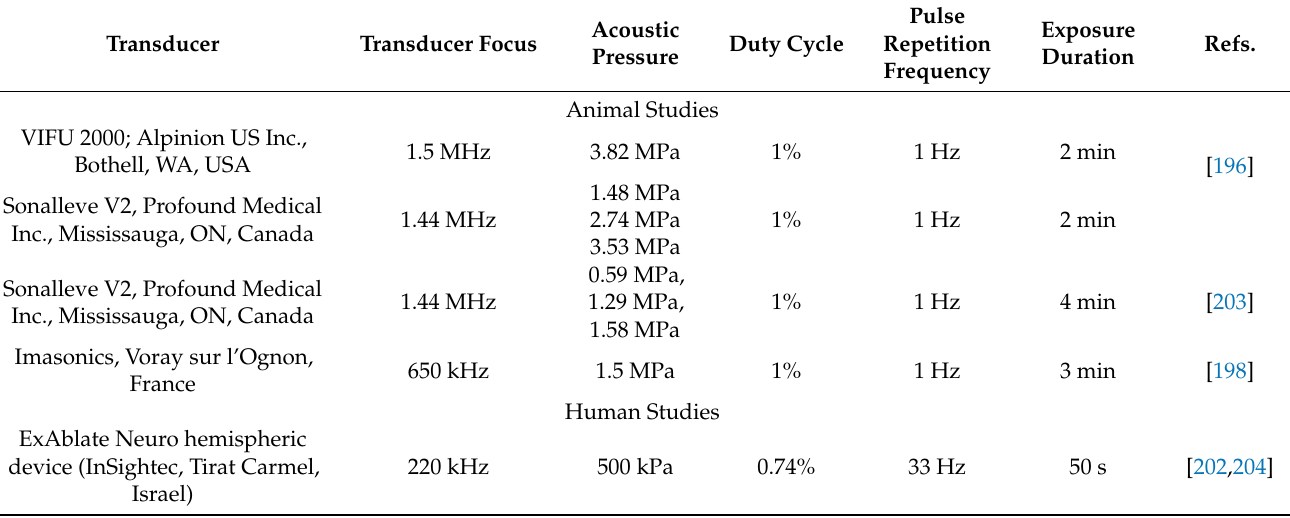
Table 2. Ultrasound parameters tested in animal and clinical studies of FUS liquid